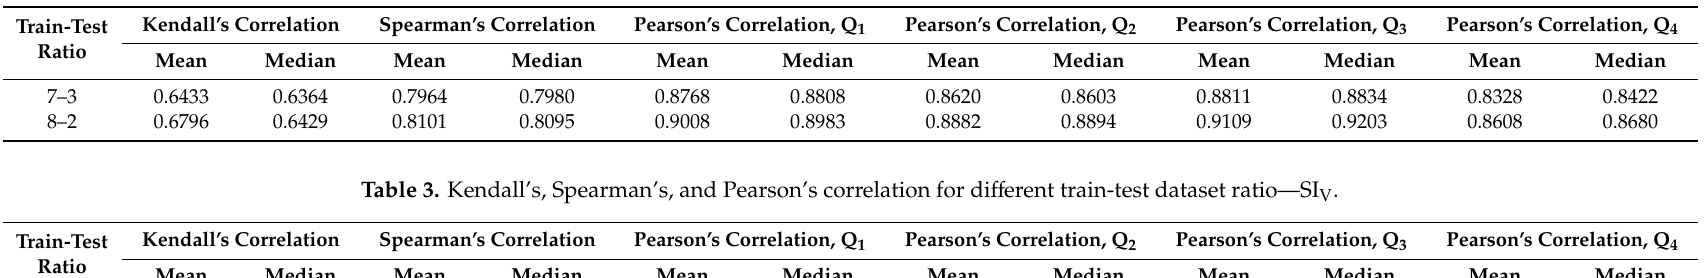
Table 2. Kendall’s, Spearman’s, and Pearson’s correlation for di ff erent train-test dataset ratio—SI H,V .